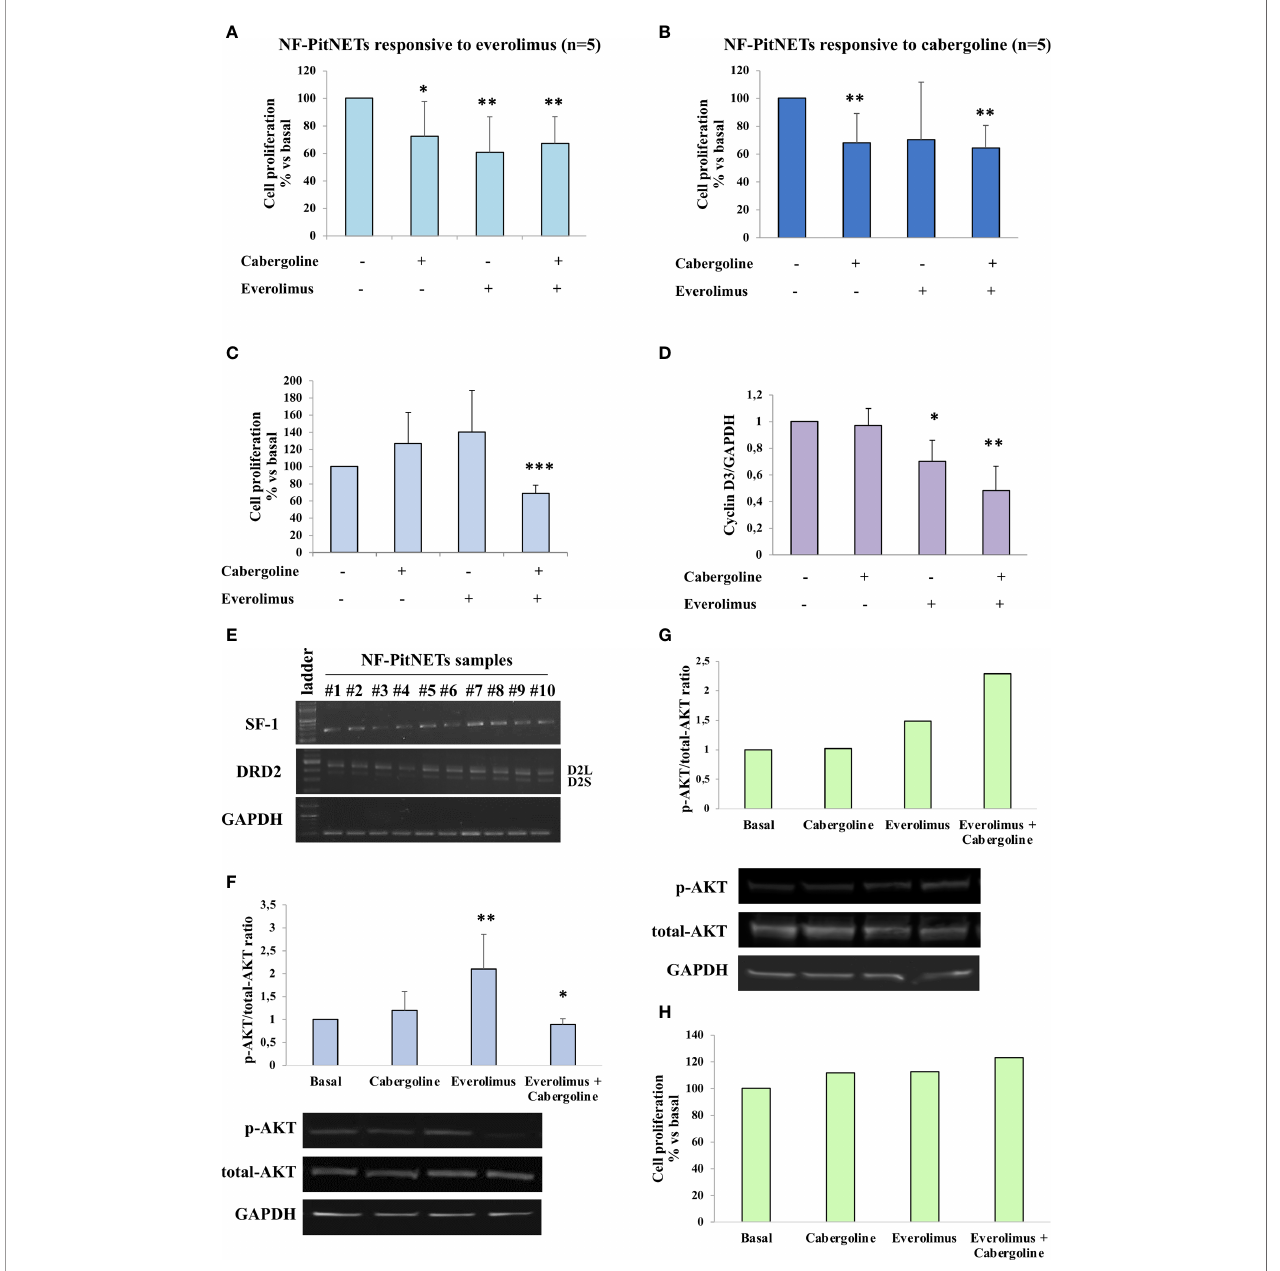
FIGURE 1 | NF-PitNET cell primary culture response to everolimus, cabergoline, and cotreatment on AKT phosphorylation and cell proliferation. Primary cultured of NF-PitNET cells (A – H) were treated with 100 nM cabergoline and 1 nM everolimus for 72 h (A – C , H) or 3 h (D, F, G) at 37°C, administered singularly or in combination. (A – C) BrdU incorporation in newly synthesized DNA was measured. Data represent the mean ± SD normalized vs. respective basal of 14 different NF-PitNETs primary cultures: n = 5 responsive to everolimus (A) , n = 5 responsive to cabergoline (B) , n = 7 resistant to both drugs but responsive to the cotreatment (C) . Each determination was done in triplicate. * p < 0.05, ** p < 0.01, *** p < 0.001 vs . corresponding basal. (D) The graph shows the quanti fi cation of cyclin D3 normalized to GAPDH (mean value ± SD from 3 primary cultures of NF-PitNETs cells). * p < 0.05, ** p < 0.01 vs. corresponding basal. (E) RT-PCR analysis of NF-PitNET samples ( n = 10) in order to detect SF-1, D2L, and D2S DRD2 isoform expression. GAPDH expression was analyzed as control. Representative images are shown. (F) The graph shows the quanti fi cation of p-AKT/total AKT normalized to the basal. Data represent mean ± SD of 6 different NF-PitNET samples. Representative immunoblots are shown. * p < 0.05; ** p < 0.01, vs. corresponding basal. (G, H) NF-PitNET primary cultured cells resistant to cabergoline, everolimus, and cotreatment were analyzed. (G) The graph shows the quanti fi cation of p-AKT/total AKT normalized to the basal and representative immunoblots. (H) Measurement of BrdU incorporation in newly synthesized